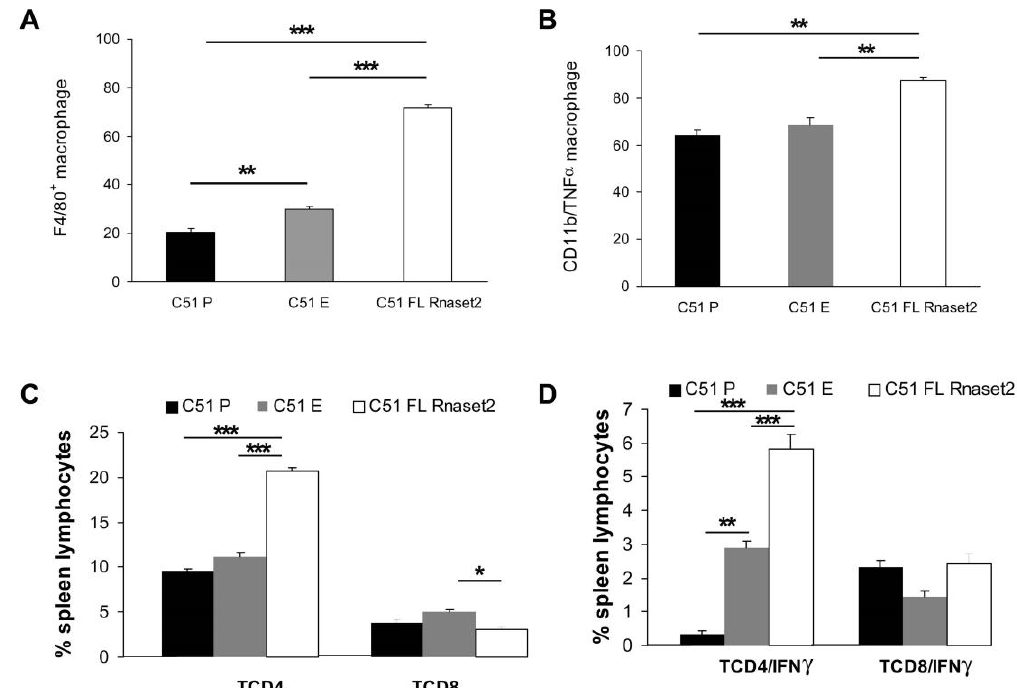
Figure 7. Cell cytometric flow assessment in spleens from groups of BALB / c mice ( N = three animals in group) at one month after tumor injection, as follows, i.e., receiving C51 P, C51 E tumor cells lines and C51 challenge in rejecting and tumor-free C51 FL Rnaset2 mice. The cytometric flow analysis has been conducted after in vitro tumor digestion to quantify: Percentage of tumor cell infiltration of F4 / 80 + mature macrophages (panel A ); percentage of TNF α -secreting CD11b + macrophages by intracellular staining, following in vitro 4 h LPS stimulation (panel B ); percentage of CD4 + and CD8 + T cells (panel C ); and percentage of IFN γ -producing CD4 + and CD8 + T cells by intracellular staining, following in vitro 4 h PMA plus ionomycin stimulation (panel D ). An ANOVA statistical analysis was performed assuming p < 0.05 as a threshold value. * p < 0.05; ** p < 0.01; *** p < 0. 001.